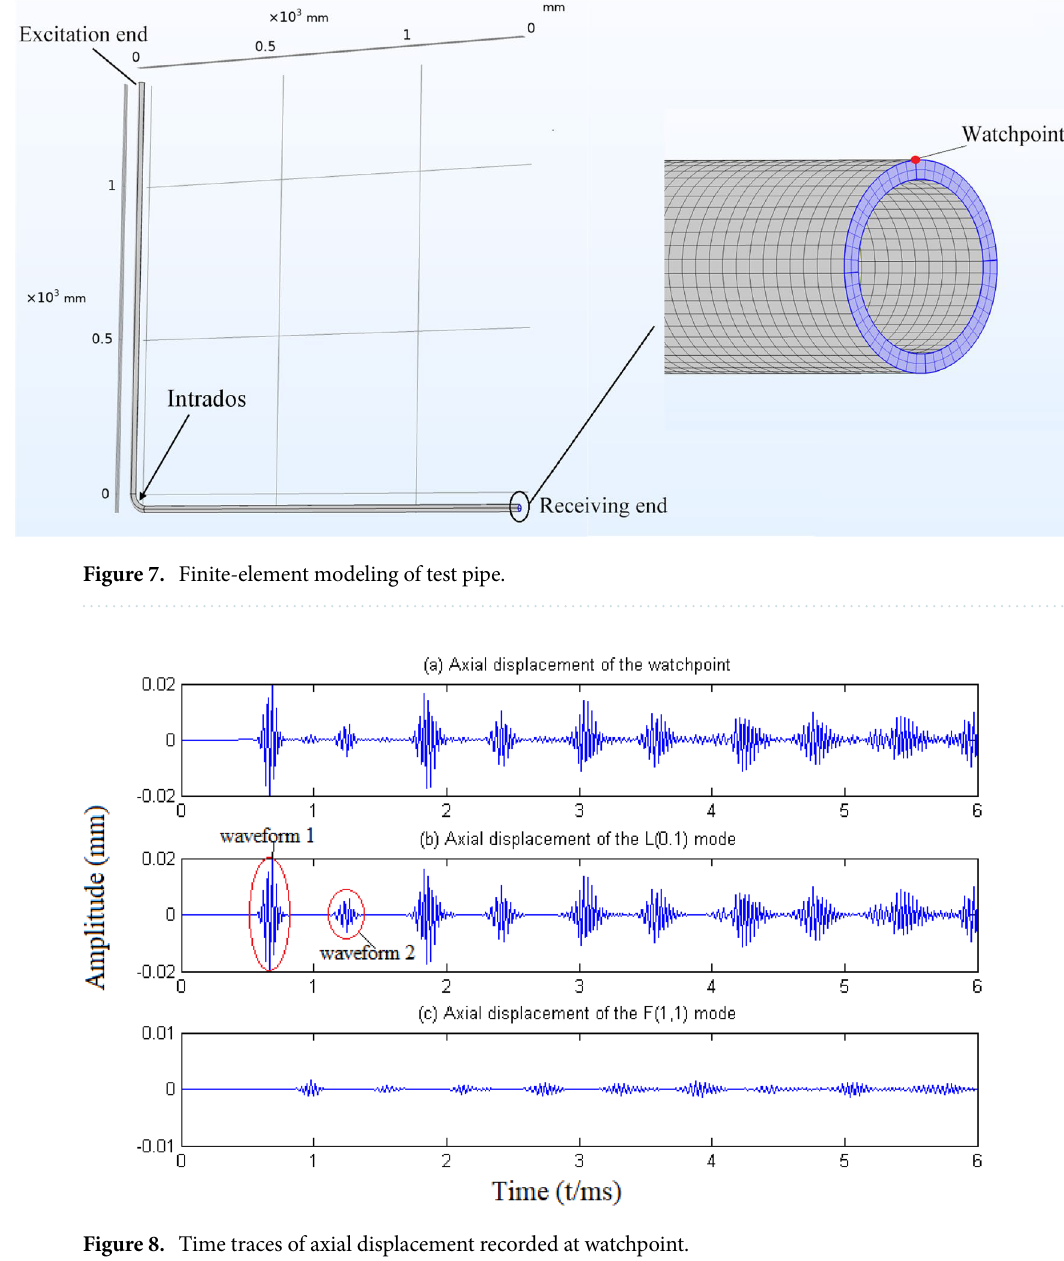
Figure 8. Time traces of axial displacement recorded at